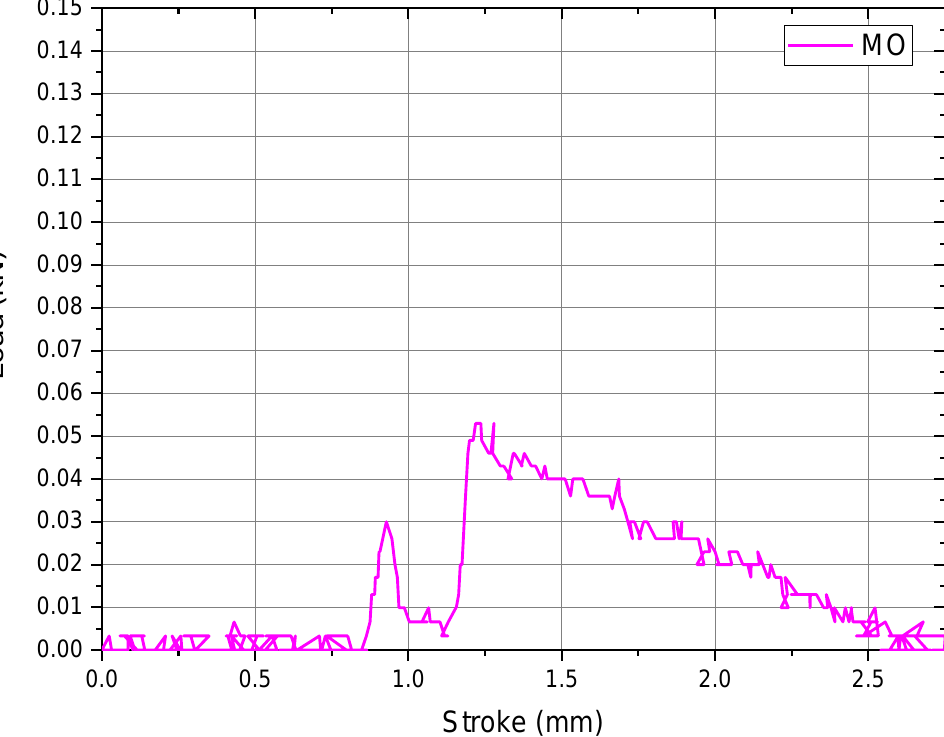
( b ) Figure 7. Open circuit potential evolution ( a ) and Tafel plots ( b ) for the CoCrFeNiMo 0.85 HEA ESD coating.